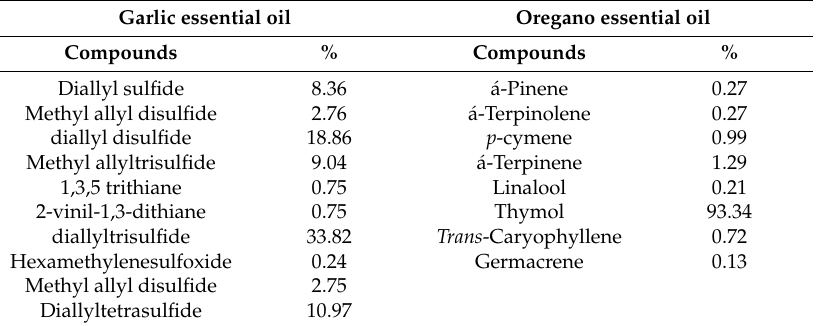
Table 2. Chemical composition of essential oils of oregano and garlic determined by GC-MS.